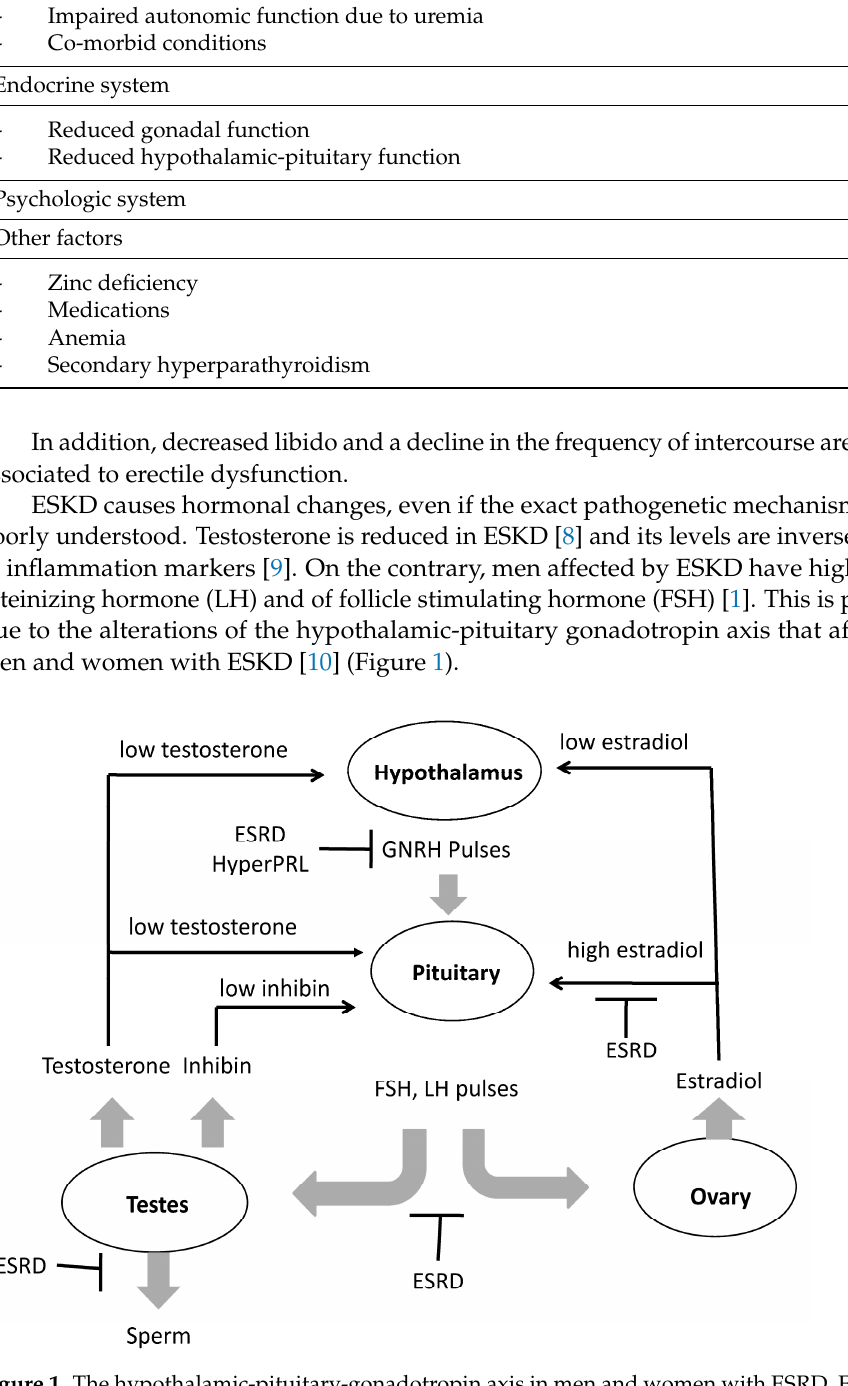
Figure 1. The hypothalamic-pituitary-gonadotropin axis in men and women with ESRD. ESRD = end stage renal disease. PRL = Prolactin. GNRH = Gonadotropin releasing hormone. FSH = Follicle stimulating hormone. LH = Luteinizing hormone.